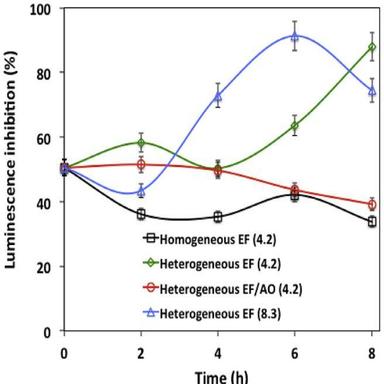
Evolution of Vibrio fisheri luminescence inhibition (Microtox® test) vs electrolysis time according to EAOP configuration and current density (in brackets, mA cm-2 ).